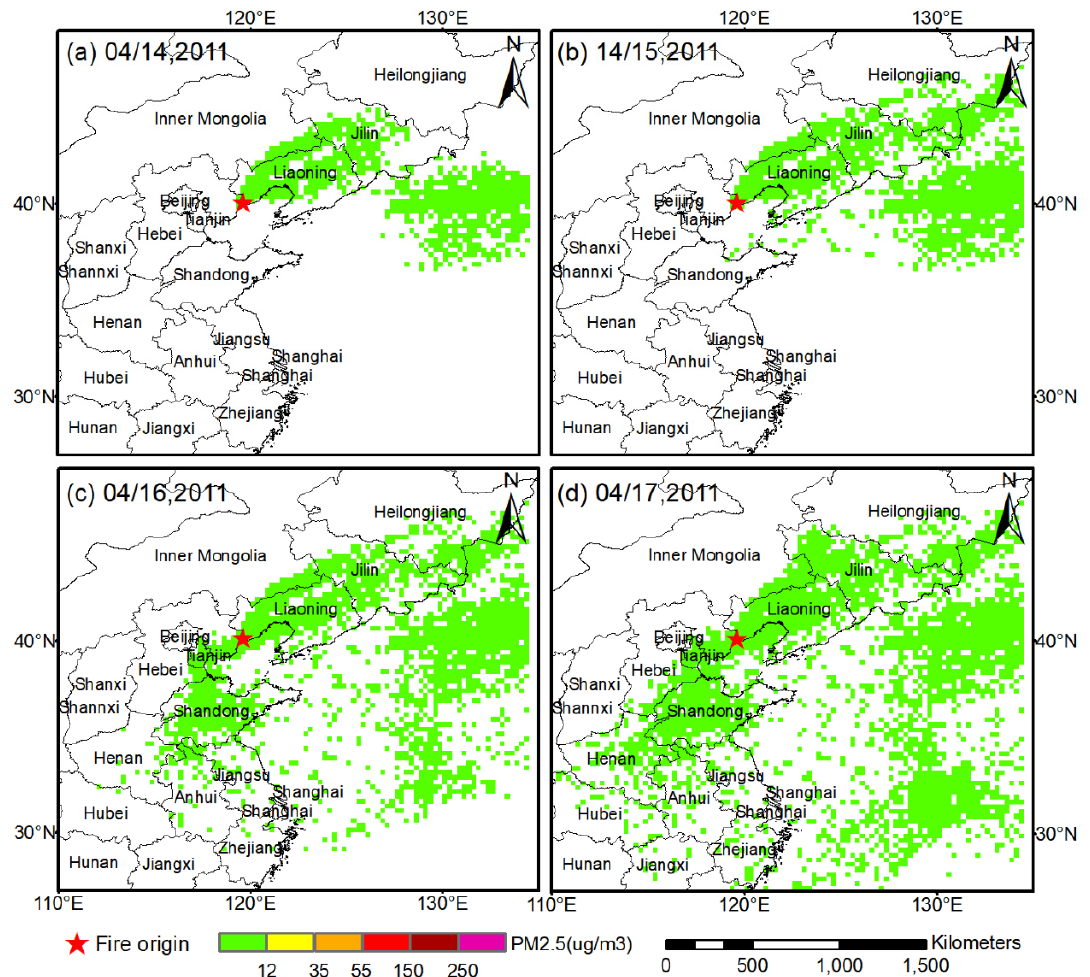
Figure9. SameasFigure3exceptfortheFuningfire. Panels( a – d Figure 9. Same as Figure 3 except for the Funing fire. Panels ( a – d ) are 14, 15, 16, and 17 April 2011, respectively.